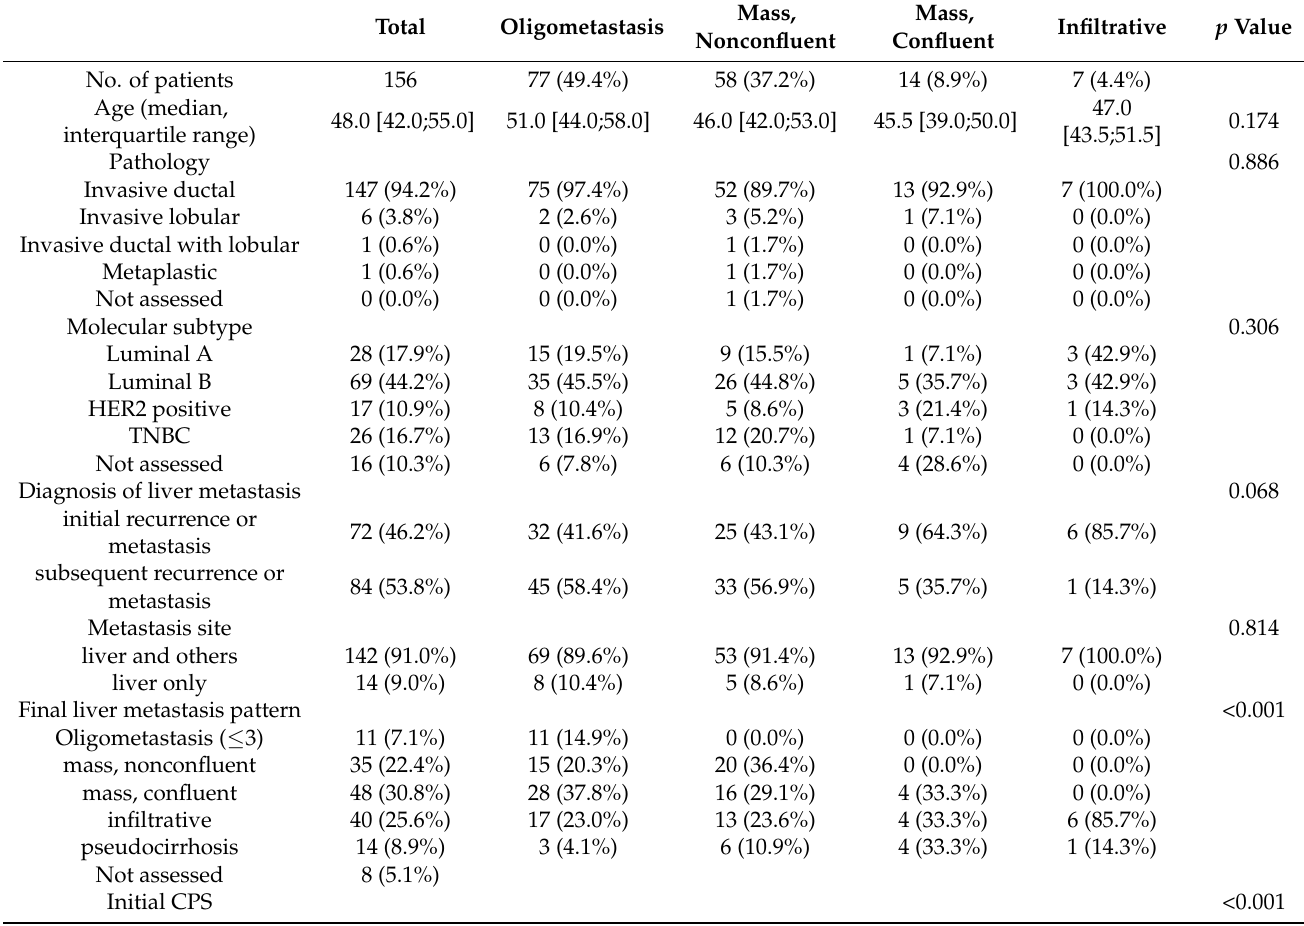
Table 1. Baseline characteristics by initial liver metastasis